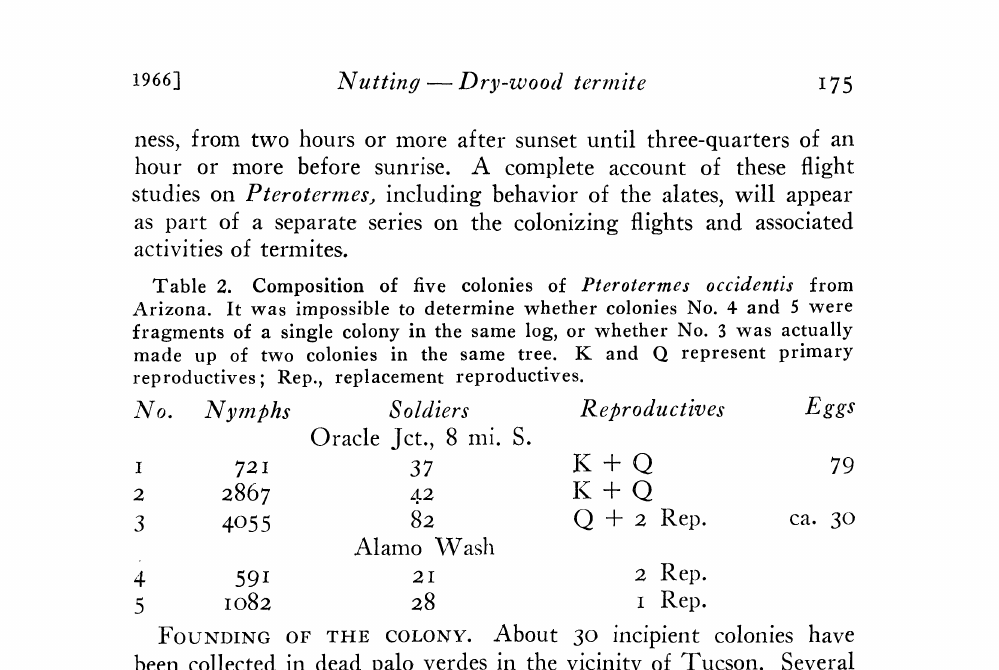
Figure 2. Scene in the foothills of the Santa Catalina Mts. north of Tucson, Arizona. To the left is the ribbed, woody skeleton of a saguaro cactus, Cereus yitlanteus; to the right, a palo verde tree, Cercidium micro- phyllum. Pterotermes has been found in these skeletons and in the dead wood of Cercidium. Figure 3. Cercid’ium Cereus association on the western slopes of the Tucson Mts. west of Tucson, Arizona. Pterotermes has been taken in this area which is typical of the Sonoran Desert in southern Arizona. Photo- graph by Peter J. Mehringer,